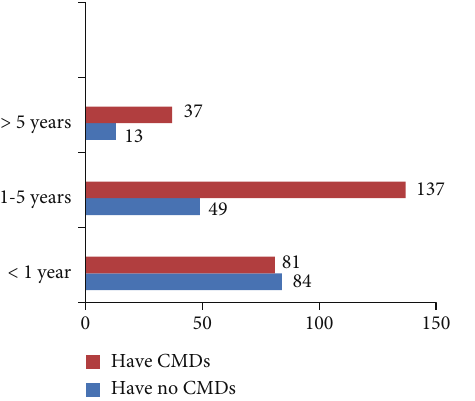
3: Duration of prison stay among prisoners in North Wollo zone correctional institutions, Northeastern